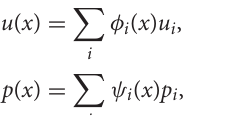
TABLE 2 | ( M2 ) Conjugate gradient method (CG). Given a matrix A and a vector b with x ∈ R